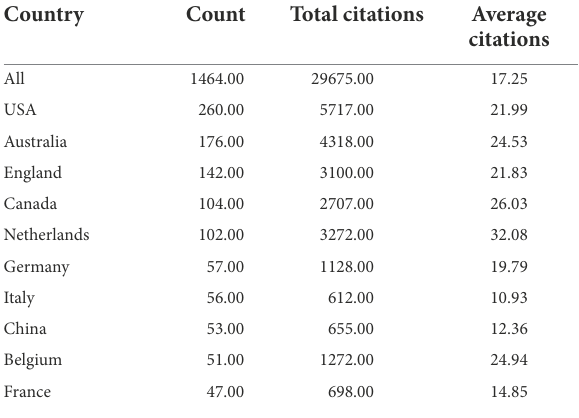
TABLE 1 Countries and regions’ publication number, centrality, and